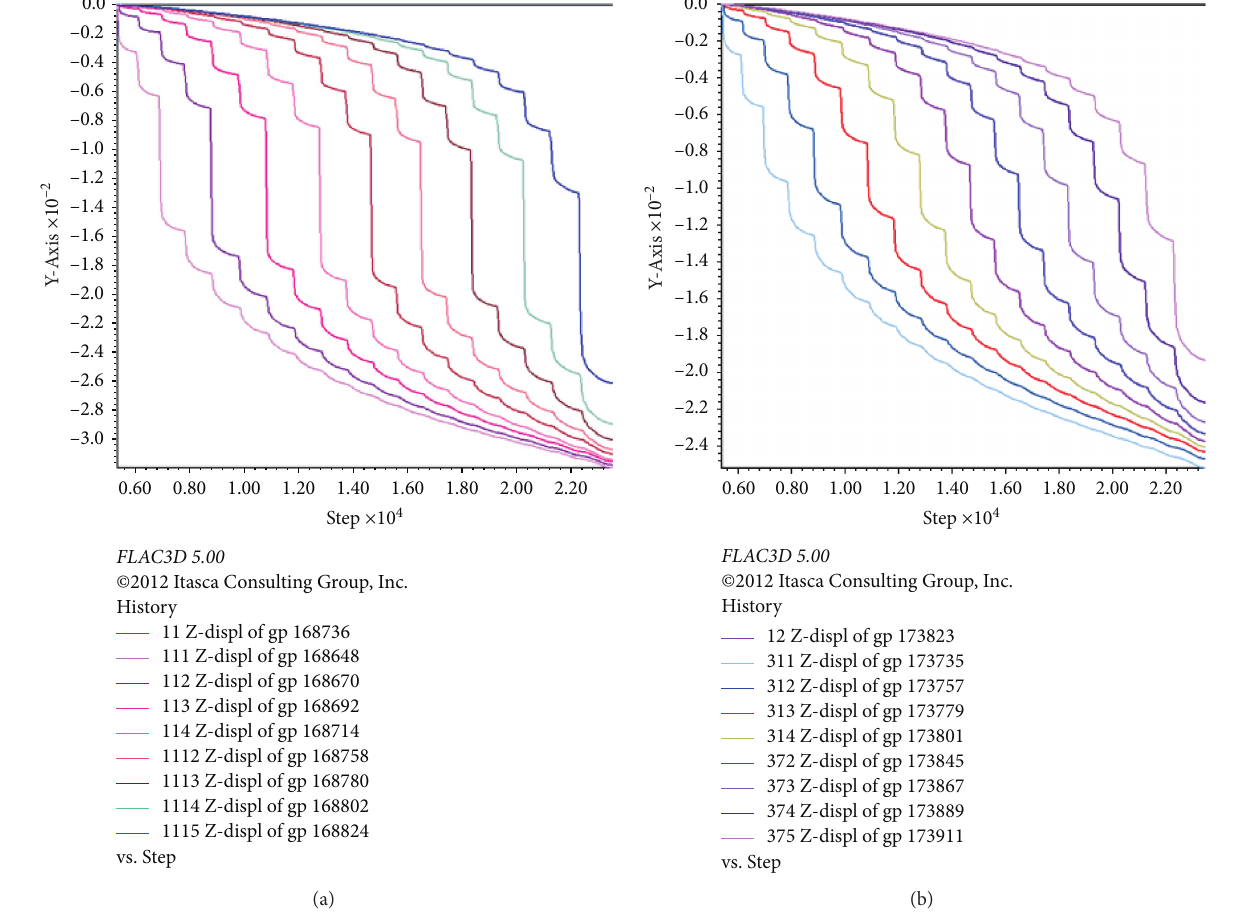
Figure 11: Vertical displacement curve of tunnel roof: (a) displacement variation curve of tunnel roof and (b) displacement variation curve of tunnel roof at 1m